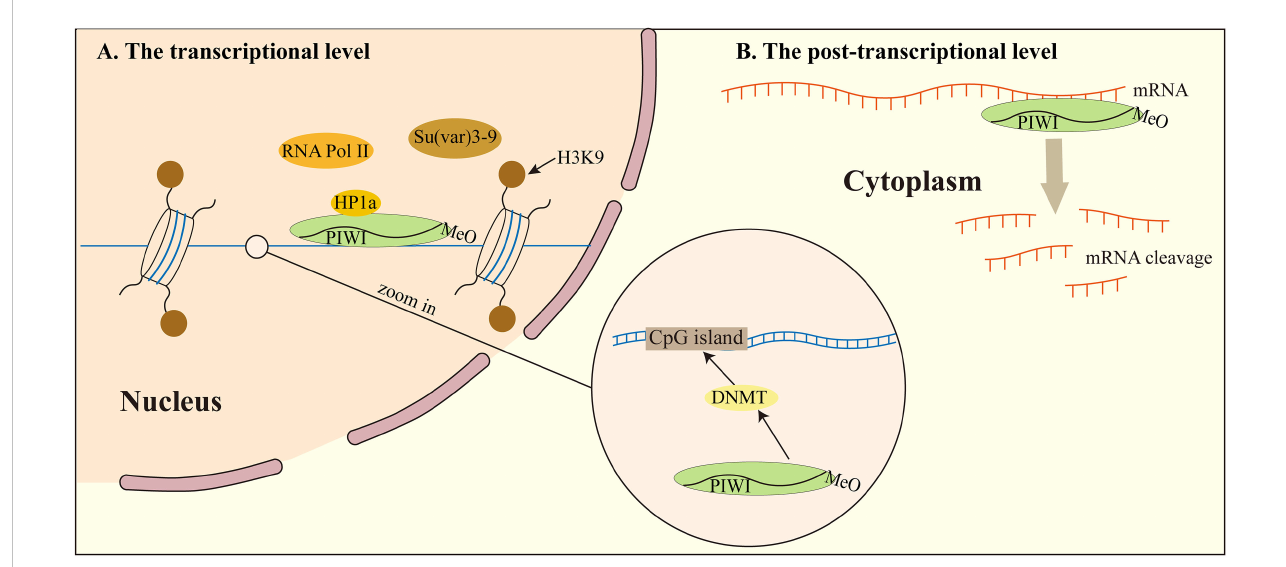
FIGURE 2 piRNA regulates transposon silencing. (A) at the transcriptional level, piRNA regulates transposon silencing through DNA methylation modi fi cation. What ’ s more, the piRNA can also silence TEs through chromosomal heterochromatinization. (B) at the post-transcriptional level, piRNA recognizes a target mRNA and mediates its degradation by deadenylating or cleaving the mRNA. DNMT, DNA